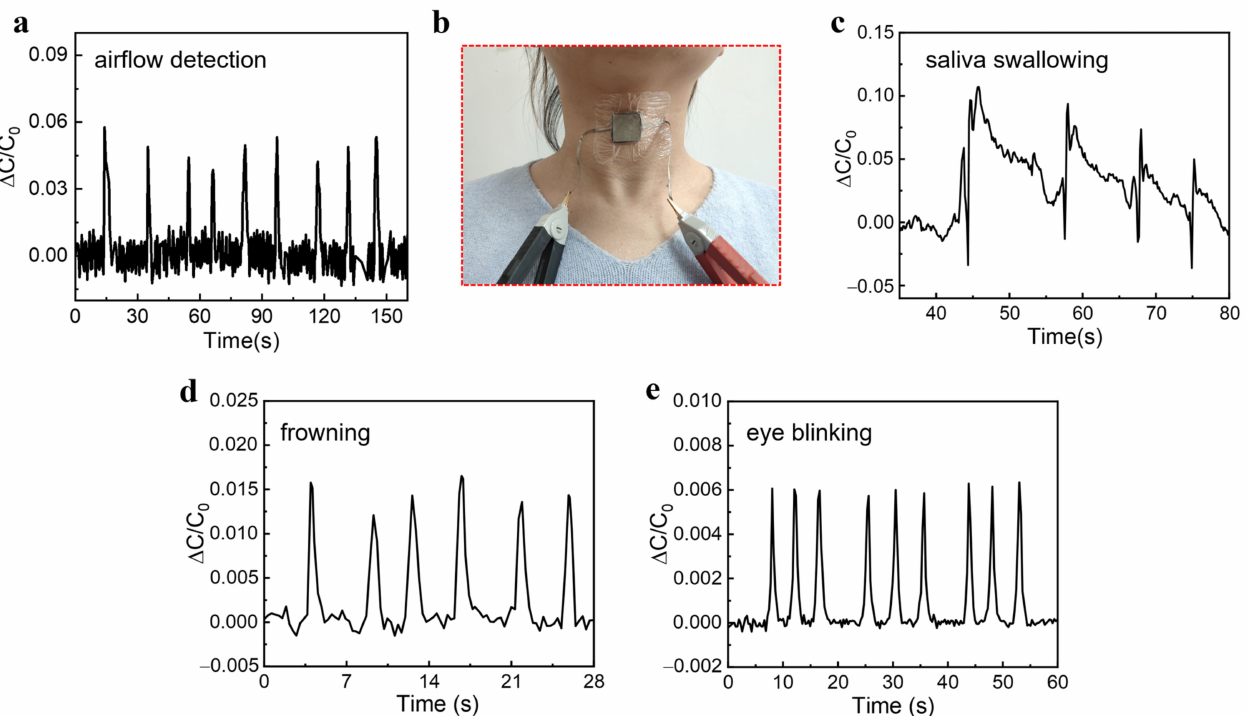
Figure 5. The micropressure monitoring of the BAFC sensor: ( a ) electrical signal of air flow detection; ( b ) photographs of the sensor attached to detect muscle movement during saliva swallowing. Time- dependent capacitance responses for the corresponding ( c ) saliva swallowing, ( d ) frowning, and ( e ) eye blinking